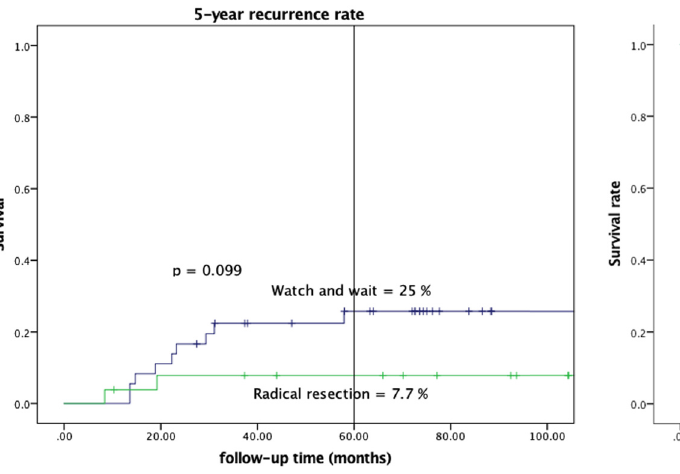
Figure 1: Local recurrence rate. Figure 2: Overall